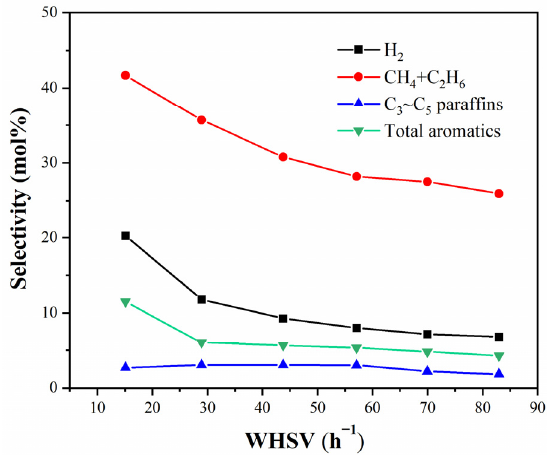
Figure 5. Selectivities of byproducts from pentene cracking over H-ZSM-5 vs. WHSV. Reaction con- ditions: total pressure, 130 kPa; partial pressure, 60 kPa; reaction temperature, 700 °C.